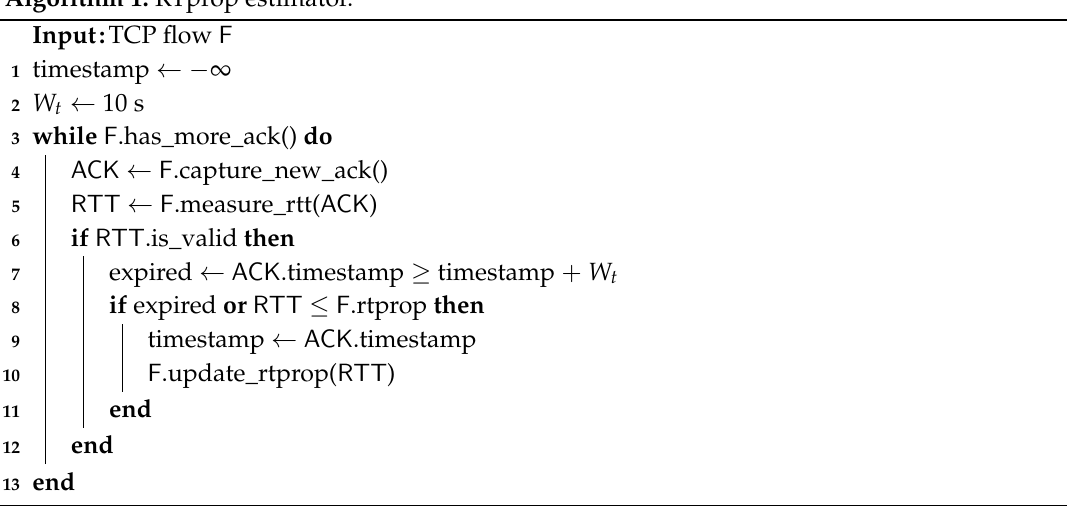
Algorithm 1: RTprop